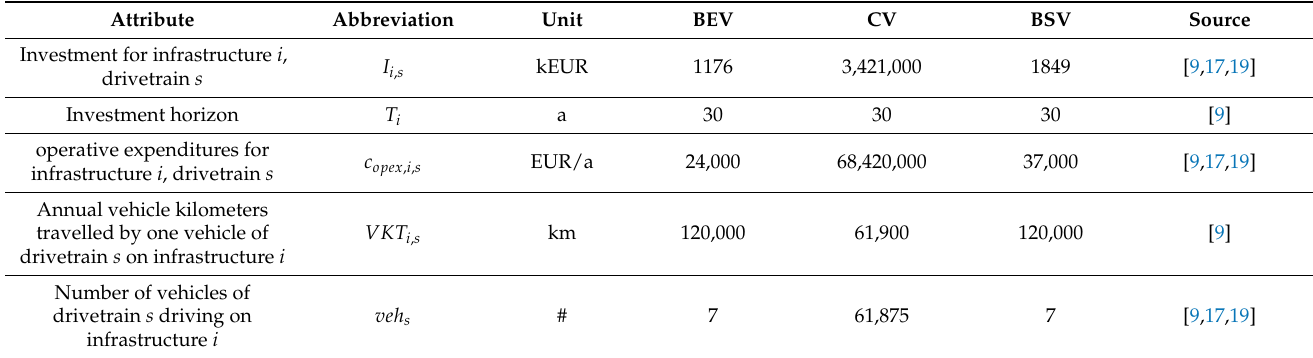
Table 4. Use case specific infrastructure parameters.